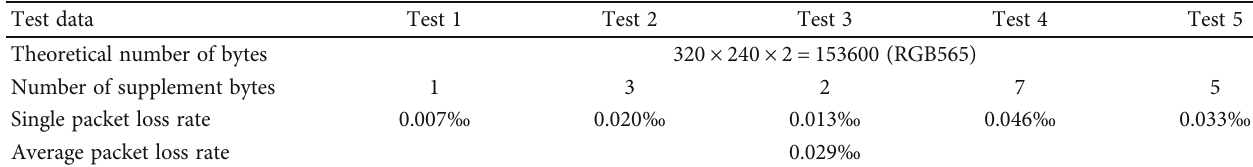
Table 2: Packet loss rates of image